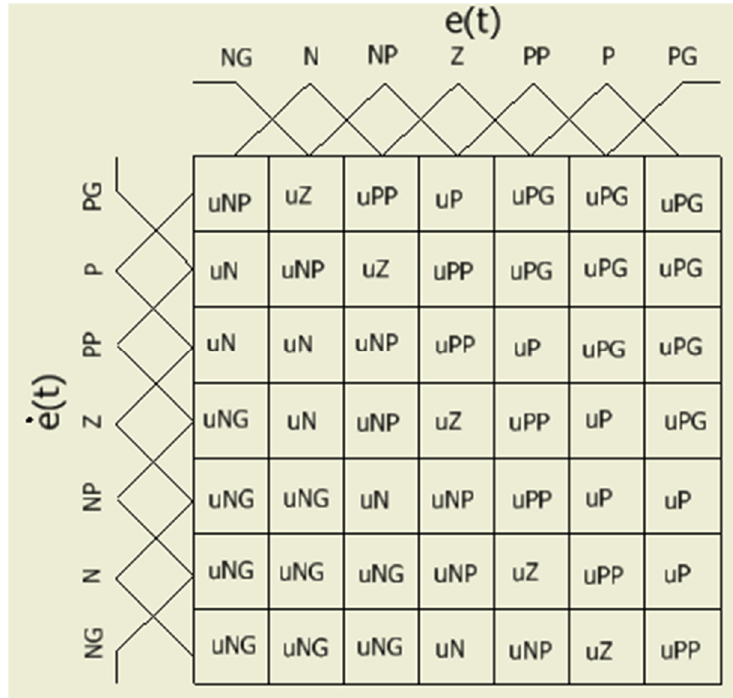
Figure 16. Matrix of rules for the proportional – derivative action.